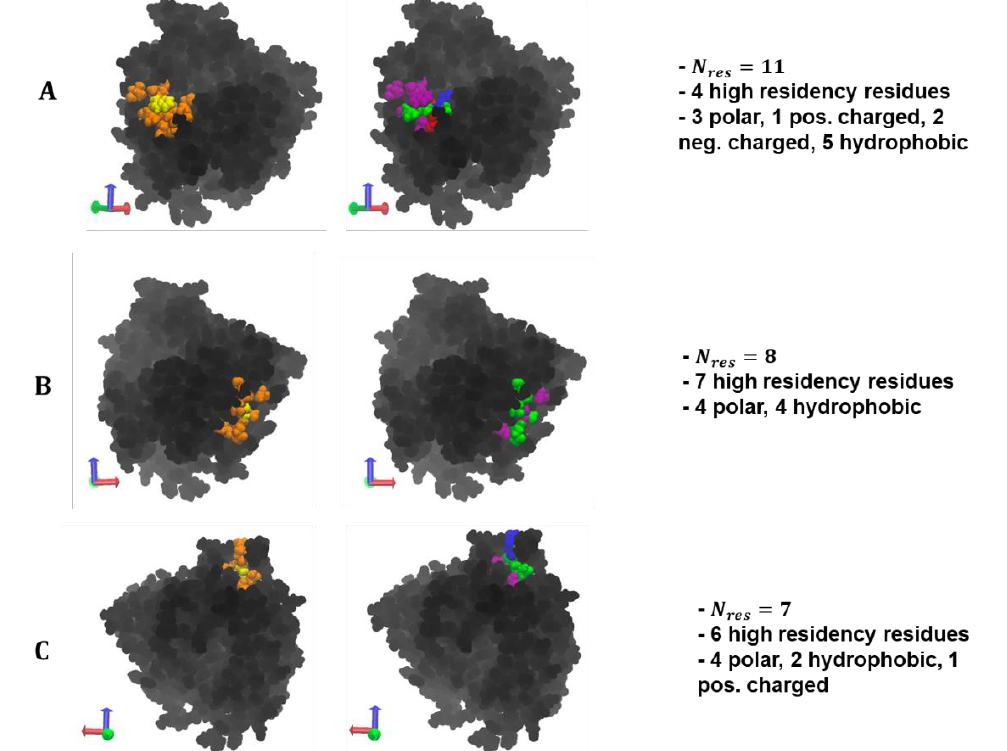
Figure 11. At low extension levels, an individual surface patch with the highest patch overlap percentage with the filtered interface is shown from ( A ) PLGA/ID2S Res OFF phase, ( B ) PEG/ID2S Res ON phase, and ( C ) PLGA-PEG/ID2S Res ON phase. In the first column of images, yellow signifies the central residue from which the patch was generated, and orange are residues that were included in the given patch by satisfying the θ cut cutoff requirement of 125°. Amino acid composition of each patch can be seen in the second column of images, where blue residues are positively charged, red residues are negatively charged, green residues are polar, and purple residues are hydrophobic. N res is the number of residues in the selected patch.